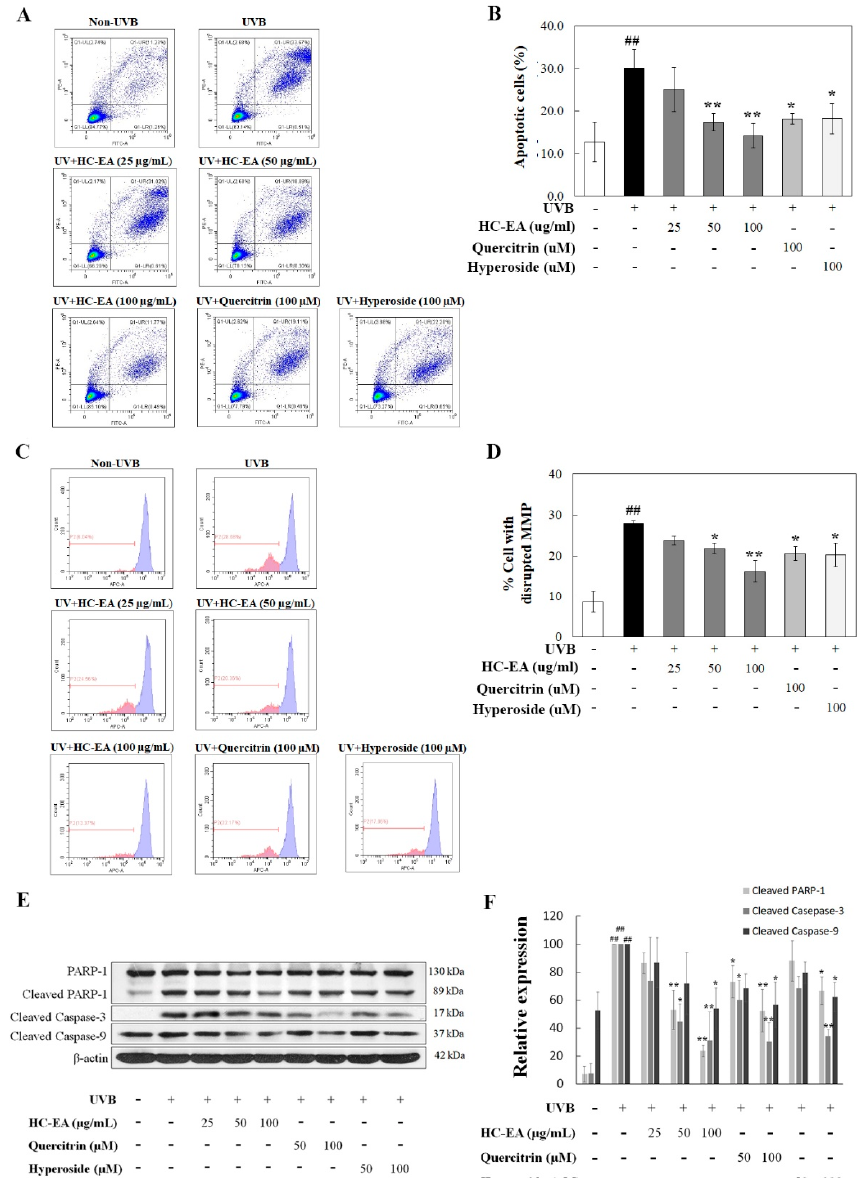
Figure 3. Anti-apoptotic effects of HC-EA and its active compounds on UVB-irradiated HaCaT cells. Flow cytometric analysis of apoptosis with representative histograms ( A ) and quantification ( B ) of apoptotic cells were performed to study the effects of HC-EA and its active compounds on UVB-irradiated HaCaT cells. HaCaT cells were pretreated with the indicated concentration of HC-EA, quercitrin, or hyperoside prior UVB irradiation (15 mJ/cm 2 ), then the apoptotic populations were detected by FITC Annexin V/PI flow cytometry after 8 h of exposure. The effect of HC-EA and its active compounds on mitochondria membrane potential were analyzed by flow cytometer. The mitochondrial membrane potential was stained with the fluorescent dye MitoView TM 633 after post-irradiation at 6 h and the result was represented in histogram ( C ) and the bar graph ( D ). The effects of HC-EA and its bioactive compounds on the expression of proteins involved in apoptosis on UVB-irradiated HaCaT cells were detected by Western blot analysis ( E ). Densitometric and statistical analysis of the apoptotic protein expression levels of cleaved PARP-1, cleaved caspase-3, and cleaved caspase-9 normalized to β -actin were performed ( F ). The experiments were repeated at least three times. * p < 0.05, ** p < 0.01, as compared to the UVB-irradiated group. ## p < 0.01 as compared to the control group. Data are representative of three independent experiments as mean ±